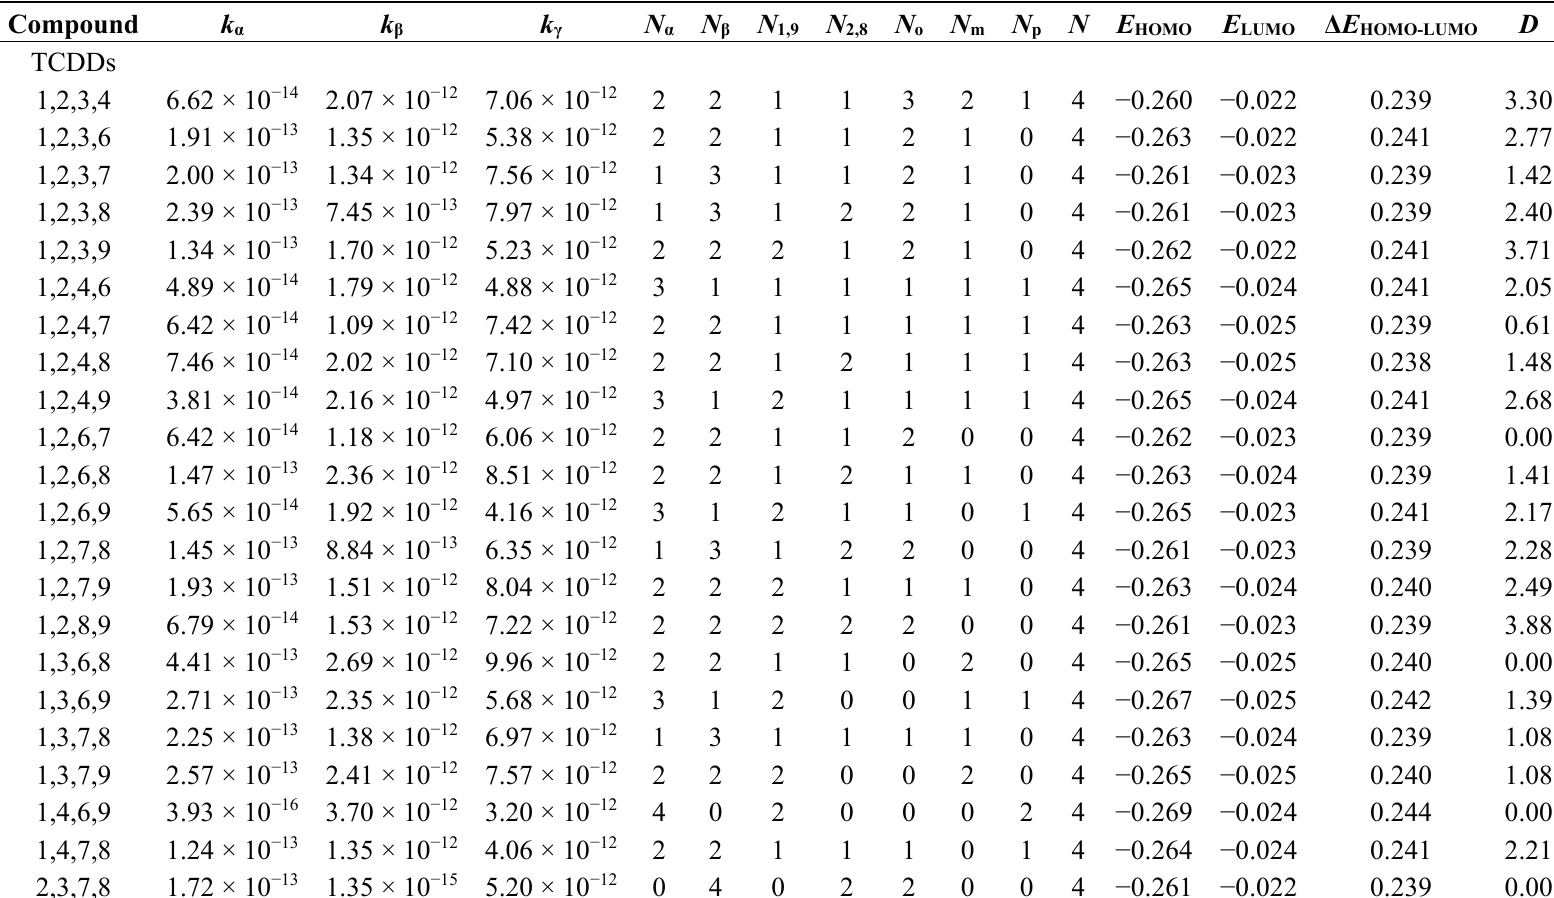
Table 2. The rate constants ( k α , k β , k γ ) of TCDDs with